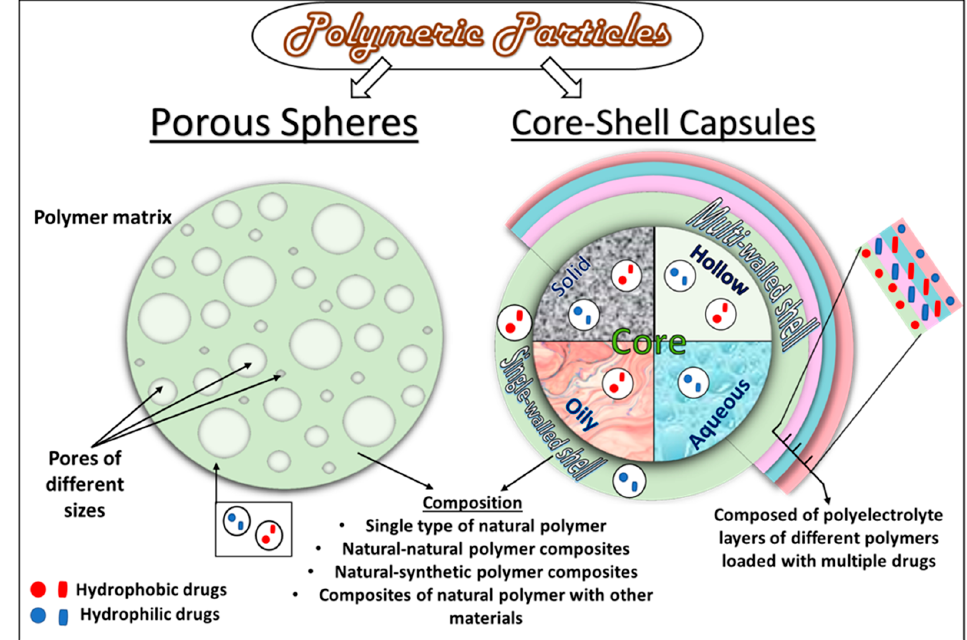
Figure 2. Structural configurations of core–shell and porous natural polymeric/protein particles.